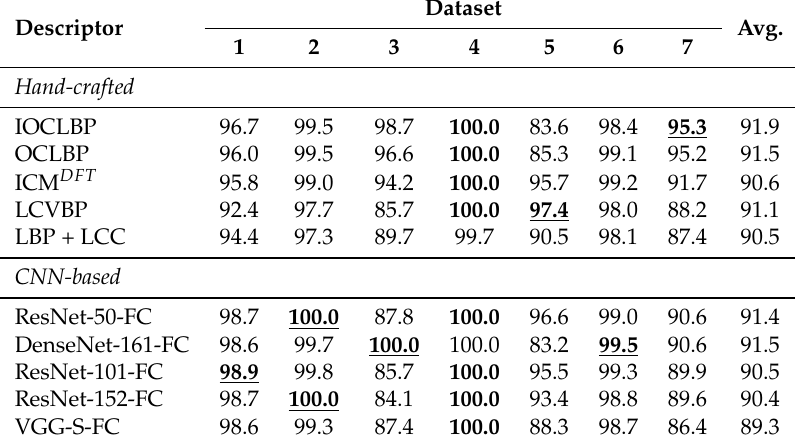
Table 6. Results of Experiment #1 (Part 1: Datasets 1–7): stationary textures acquired under steady imaging conditions. Figures report overall accuracy by dataset. Boldface denotes the highest value; underline signals a statistically-significant difference between the best hand-crafted and the best